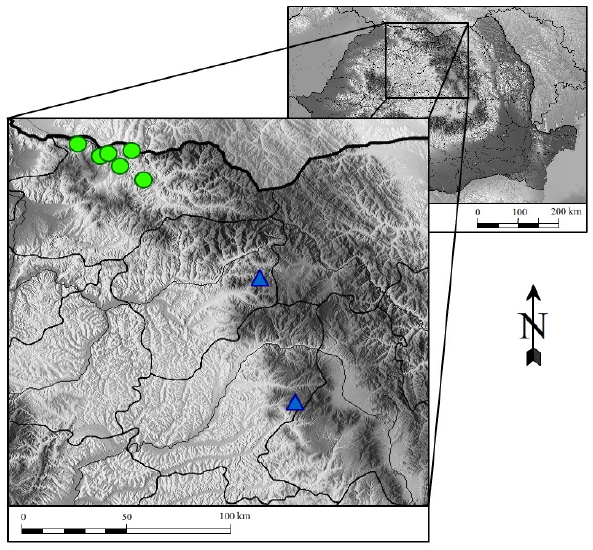
Fig. 2. Distribution of Clathrus archeri in Romania: